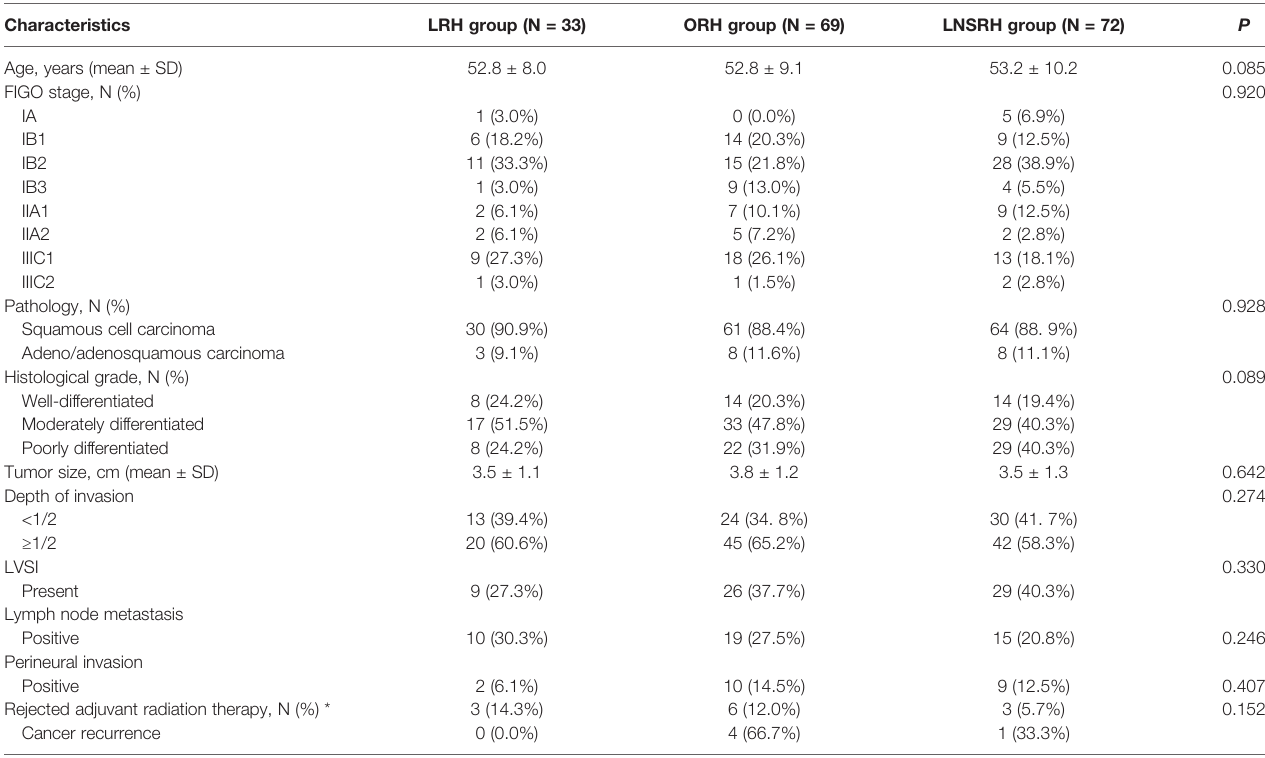
TABLE 1 | Clinical and histopathological characteristics of study participants.